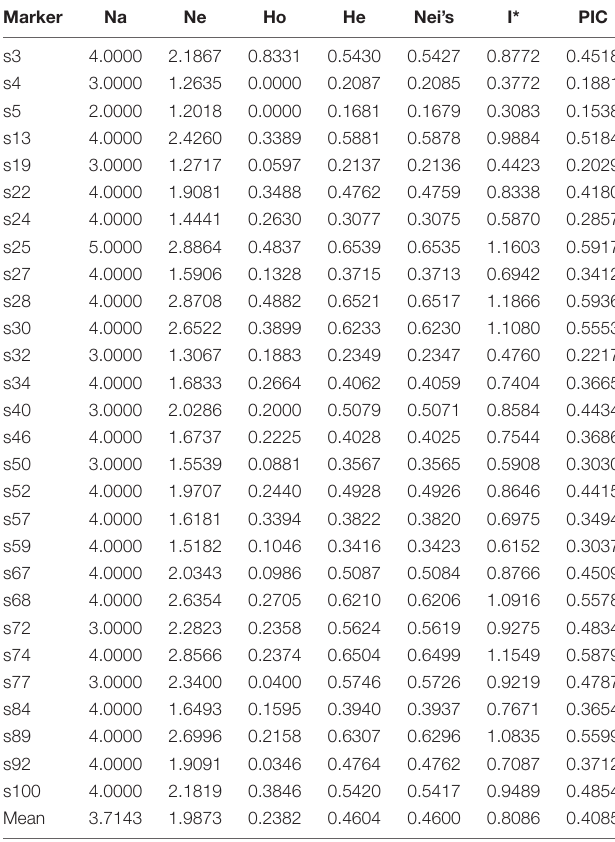
TABLE 1 | Genetic diversity parameters for original genetic population at the 28 SSR markers.